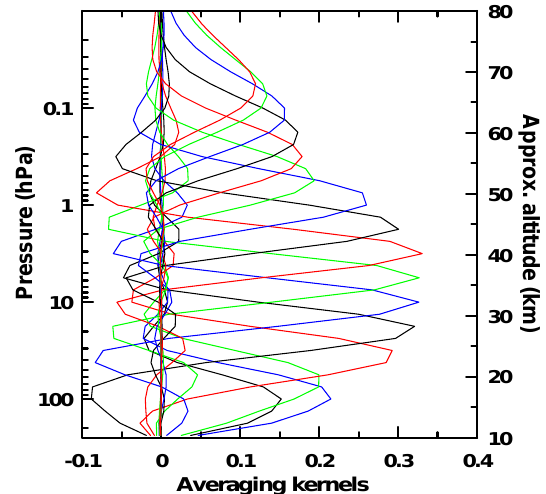
Figure 2. Typical averaging kernels for the MOPI1 instrument based on 6h of spectral integration. Averaging kernels are shown for every second level, with the averaging kernels in blue shown at 100, 10, 1, and